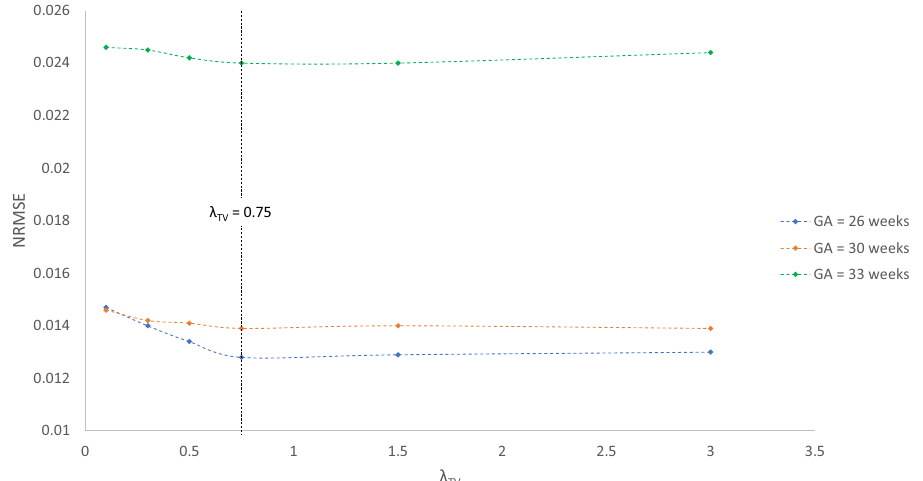
Figure 4. Normalized root mean squared error (NRMSE) between SR reconstructions from simulated data at a GA of 26, 30 and 33 weeks respectively and the corresponding 3D HR ground truth depending on the weight (cid:31) of the TV regularization. Six values of (cid:31) are tested: 0.1, 0.3, 0.5, 0.75, 1.5 and 3. The NRMSE is minimal for (cid:31) = 0.75.